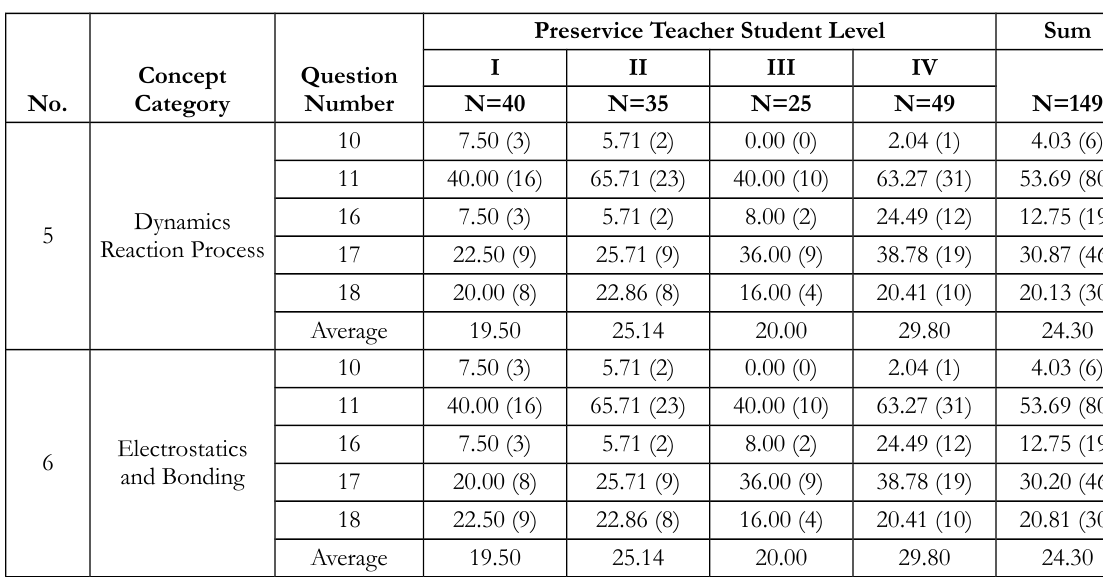
Table 5. Percentage of preservice teachers who answered correctly in six concept